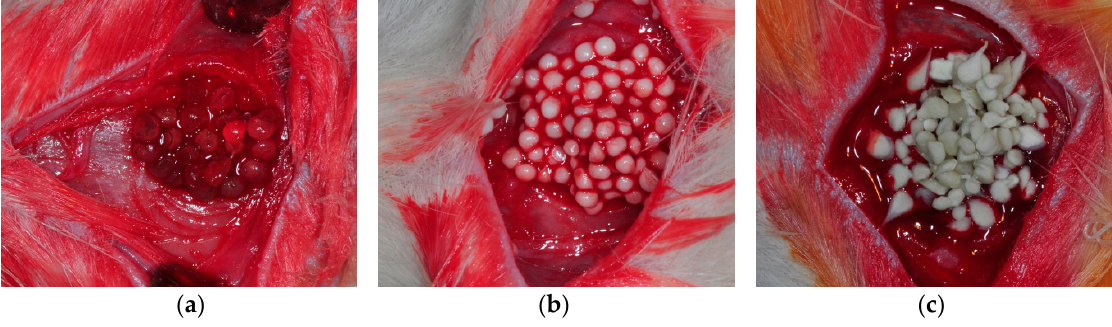
Figure 8. ( a ) Alginate; ( b ) HA/alginate; and ( c ) SF/HA/alginate beads were grafted into rat calvarial defects.